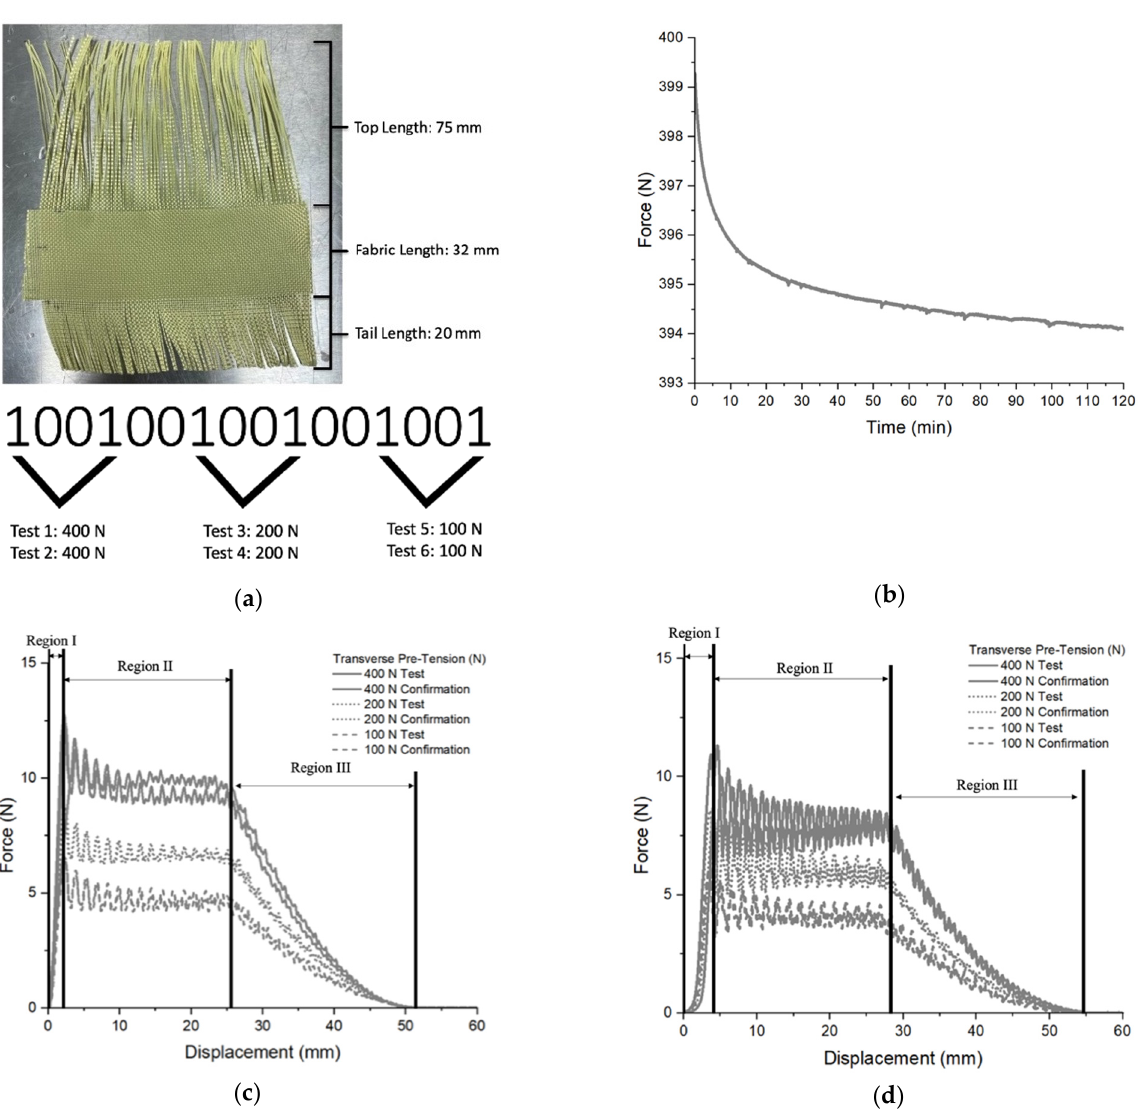
Figure 4. Quasi ‐ static yarn pull ‐ out test setup in an Instron machine.